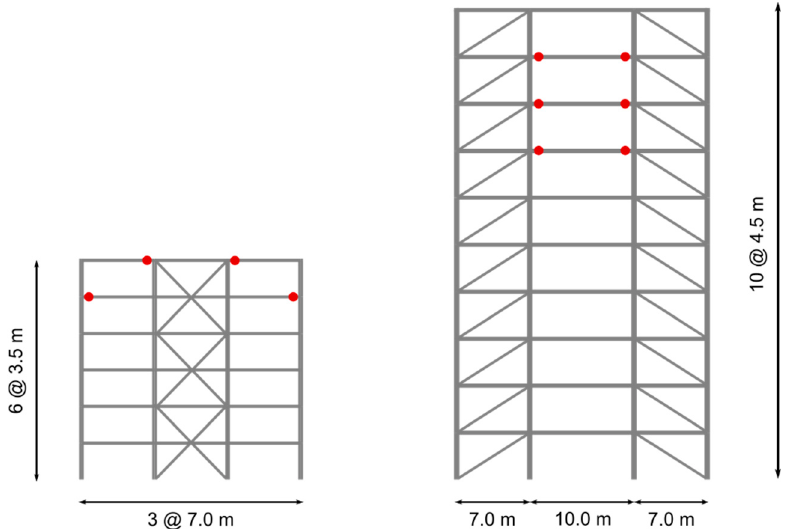
Figure 1. Steel-frame buildings and plastic hinges (red dots) considered. Although not specific code was used for designing the frames as mentioned before, they correspond to the strong-column weak-beam philosophy contained in many relevant standards (e.g., American Society of Civil Engineers (ASCE 7–16) [28]; IBC-2018 [29]; NTCS-2017 [30]; Eurocode [31]). For the six-story building, the first horizontal vibration period is T 1h = 0.398 s, the second is T 2h = 0.108 s and the third one is T 3h = 0.052 s, as shown in Figure 2. The same corresponding periods, but for the vertical response are T 1v = 0.173 s, T 2v = 0.164 s and T 3v = 0.060 s, respectively, as in Figure 3.